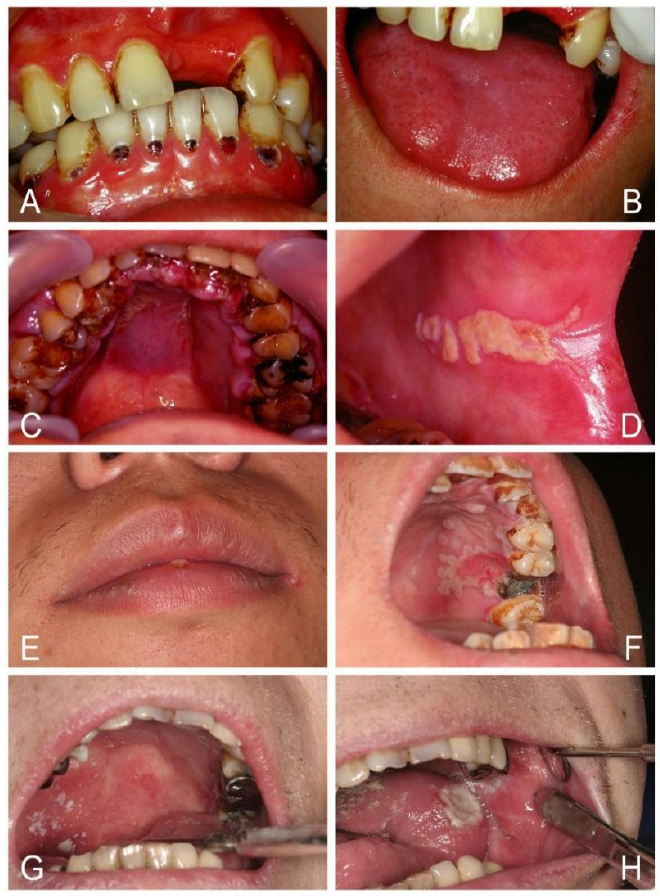
Figure 1. Oral candidosis can be a mark of systemic disease. ( A , B ) Erythematous candidosis, angular cheilitis, and rampant cervical caries led to the diagnosis of diabetes mellitus and iron deficiency anemia in a 30-year-old male who drank soda daily instead of water. ( C , D ) Pseudomembranous candidosis and diffuse gum hyperplasia with cyanotic change led to the diagnosis of acute myeloid leukemia in a 32-year-old man. ( E , F ) Cheilocandidosis and pseudomembranous candidosis around a necrotic ulcer over the palate led to the diagnosis of HIV infection in a 28-year-old man. ( G , H ) Pseudomembranous and erythematous candidosis with a necrotic tongue ulcer led to the diagnosis of severe leukopenia in a 33-year-old woman.